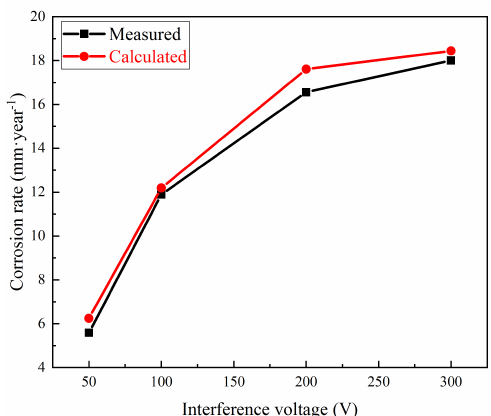
Figure 12. Measured and calculated corrosion rates under HVDC